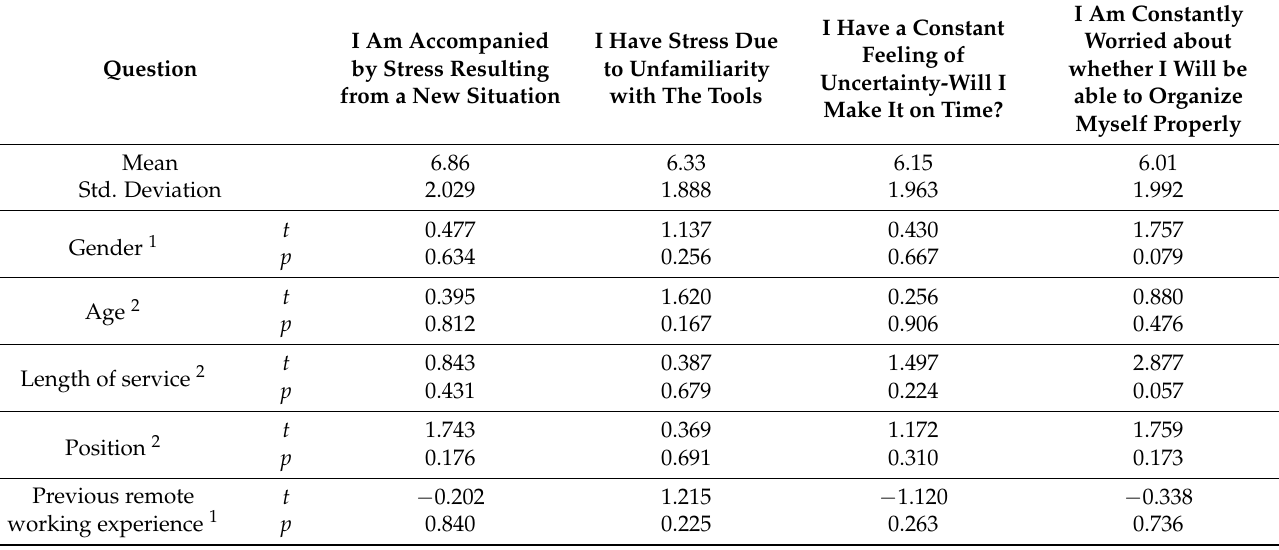
uncertainty among respondents and suggest a wide variation in the experiences. Table 3. Emotions associated with working conditions. Table 3. Emotions associated with working